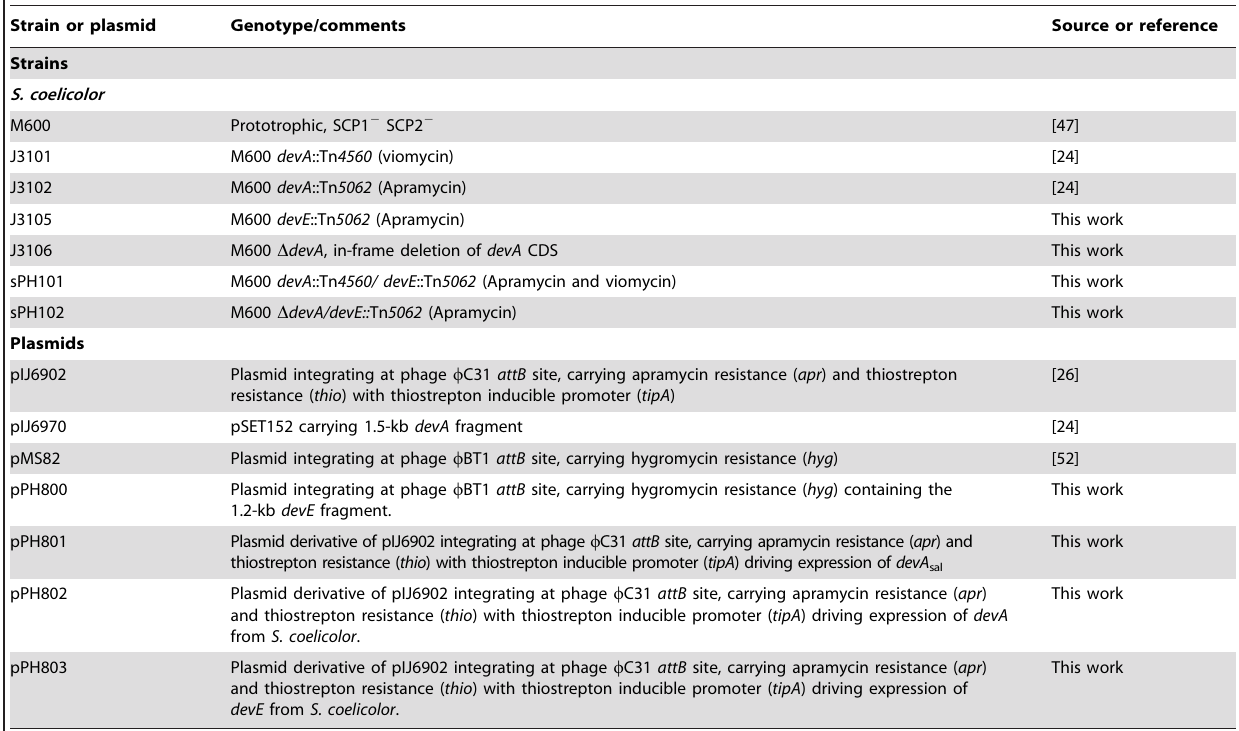
Table 1. Strains and plasmids used in this study.